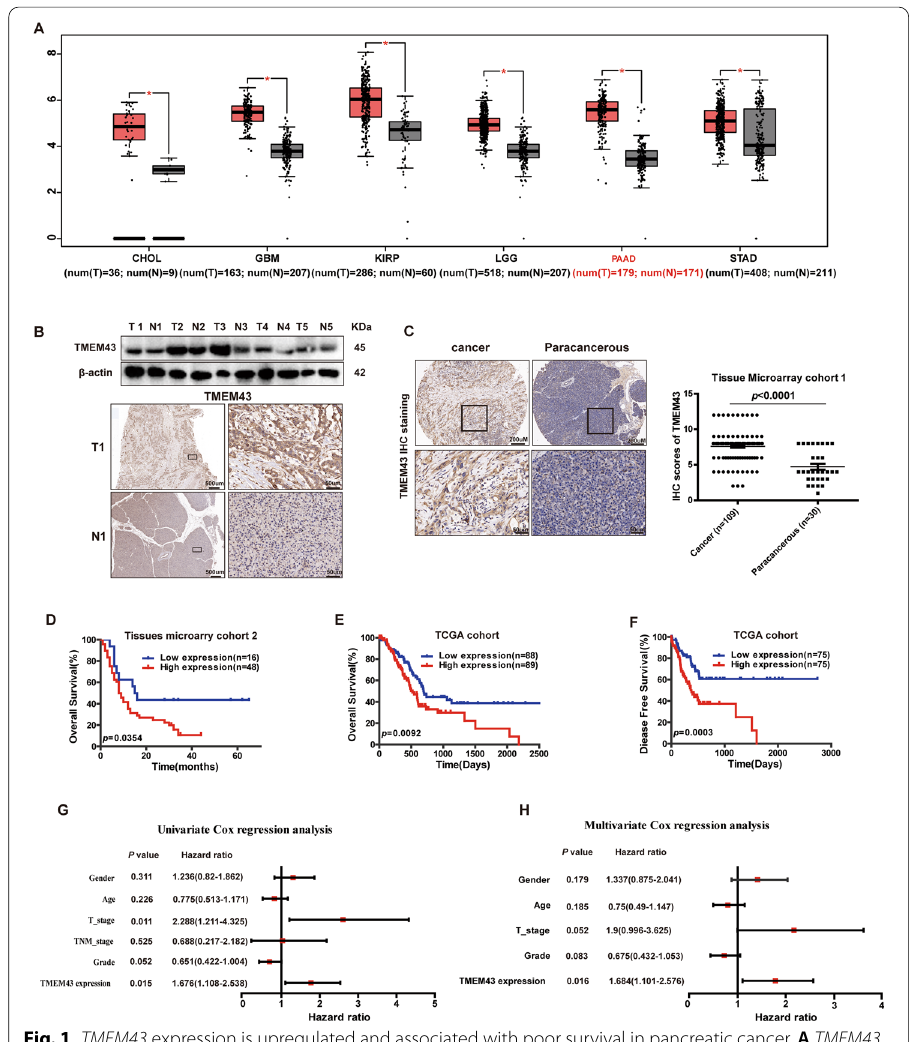
Fig. 1 TMEM43 expression is upregulated and associated with poor survival in pancreatic cancer. A TMEM43 mRNA expression levels in different tumor samples and the corresponding normal samples (http:// gepia. cancer- pku. cn/). B Western blotting and immunohistochemistry (IHC) assays showed the expression levels of TMEM43 in pancreatic cancer tissue samples and matched normal samples ( n 5). Scale bar (left) 500 μm, = = scale bar (right) 50 μm. C IHC showing the expression of TMEM43 in pancreatic cancer tissues and normal = tissues in TMA cohort 1. Scale bar (left) 200 μm, scale bar (right) 50 μm. D Kaplan–Meier curve analysis = = showing the association of TMEM43 protein expression levels with patient survival using pancreatic cancer TMA cohort 2. E , F Kaplan–Meier curve analysis showing the correlation of TMEM43 mRNA levels with survival using the TCGA dataset. G , H Univariate and multivariate Cox regression analyses were performed in the TCGA pancreatic cancer dataset. * P <